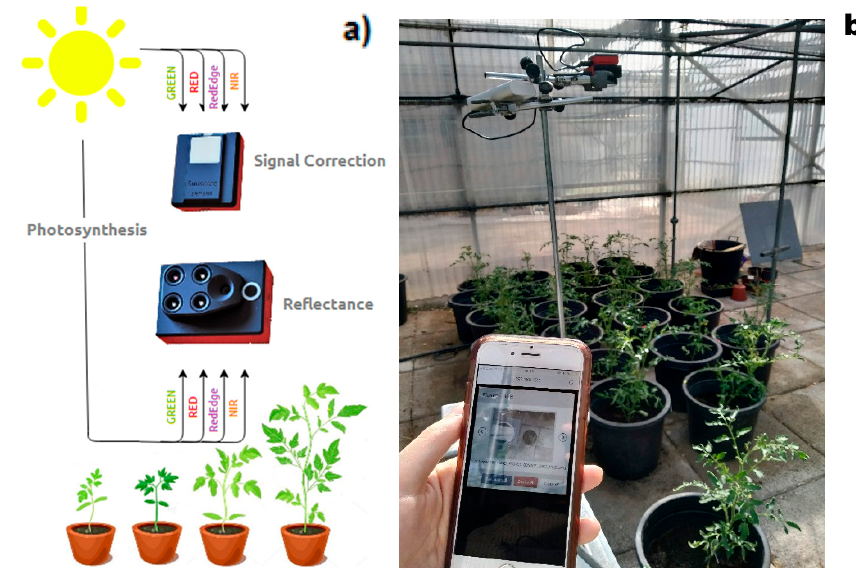
Figure 3. Overview of the image acquisition system. ( a ) Conceptual image acquisition scheme. ( b ) Bracket support with camera and signal correction device measuring tomato plants in early stages.